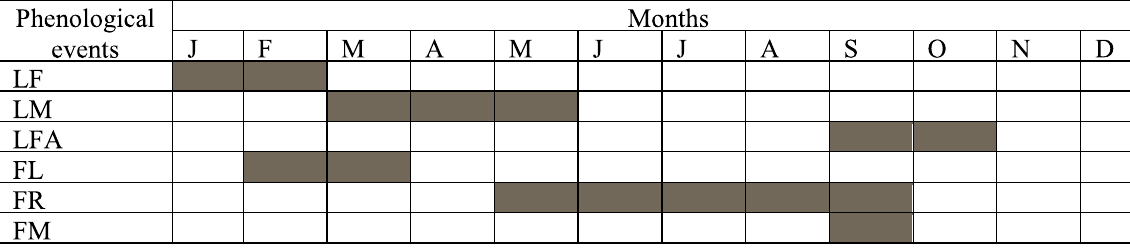
Table 1 Phenological calendar of E.